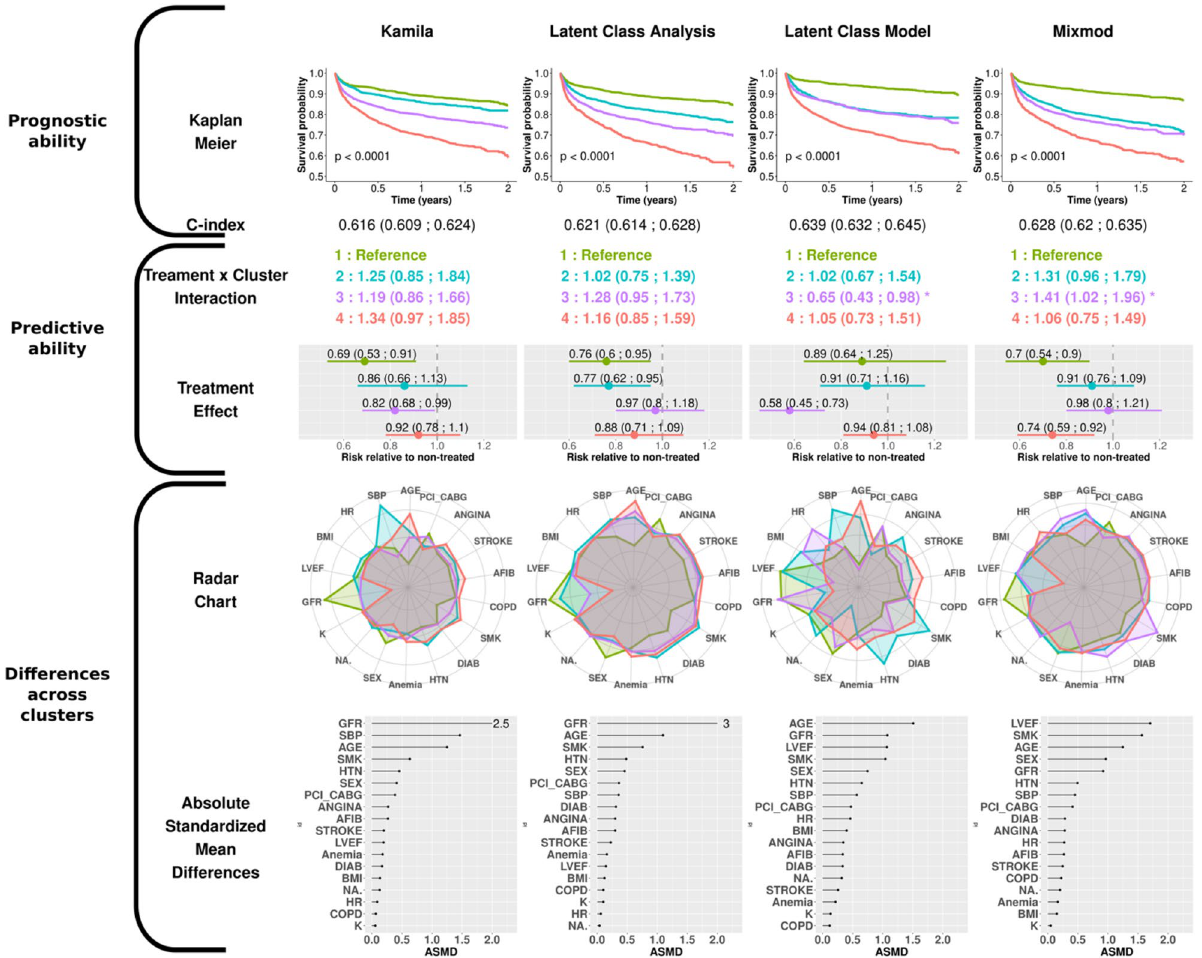
Figure 4. Results obtained with the model-based clustering algorithms in the EPHESUS dataset. Radar charts were created from the means (per, by) group on scaled values (dichotomous and ordinal variables were coded numerically for convenience). The dot charts show the average Absolute Standardized Mean Difference (ASMD) over all clusters. This figure title was generated using R (R: A Language and Environment for Statistical Computing, R Core Team, R Foundation for Statistical Computing, Vienna, Austria, 2020, https ://www.R-proje